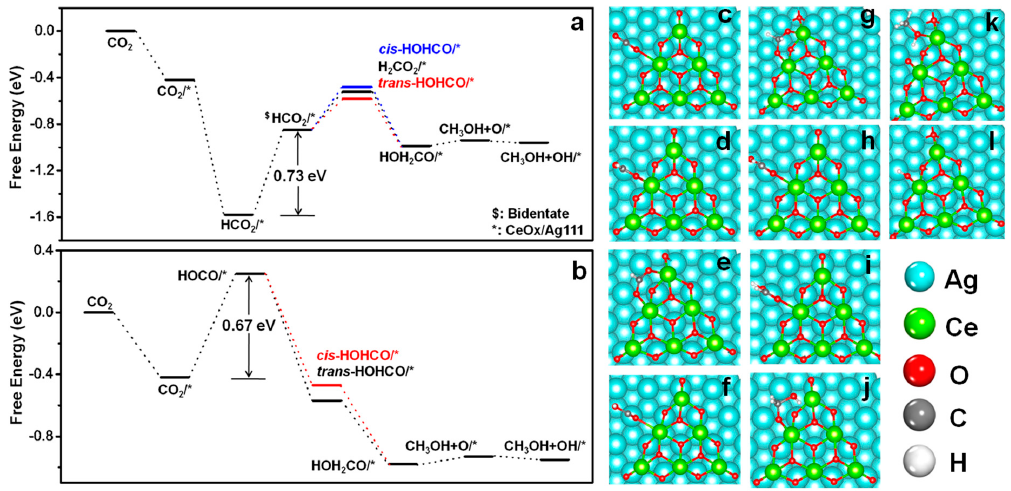
Figure 4. Free energy diagrams for the formation of formic acid and methanol. ( a ) HCO 2 * path. ( b ) HOCO* path. ( c – l ) most stable structures for important stationary point involved in the formation of formic acid and methanol. ( c ) CO 2 *, ( d ) HCO 2 *, ( e ) HCO 2 * (bidentate-coordination), ( f ) HOCO*, ( g ) H 2 CO 2 *, ( h ) trans-HOHCO, ( i ) cis-HOHCO, ( j ) HOH 2 CO 2 *, ( k ) (CH 3 OH+O)*, ( l ) OH*. *: CeO x /Ag(111) catalyst.